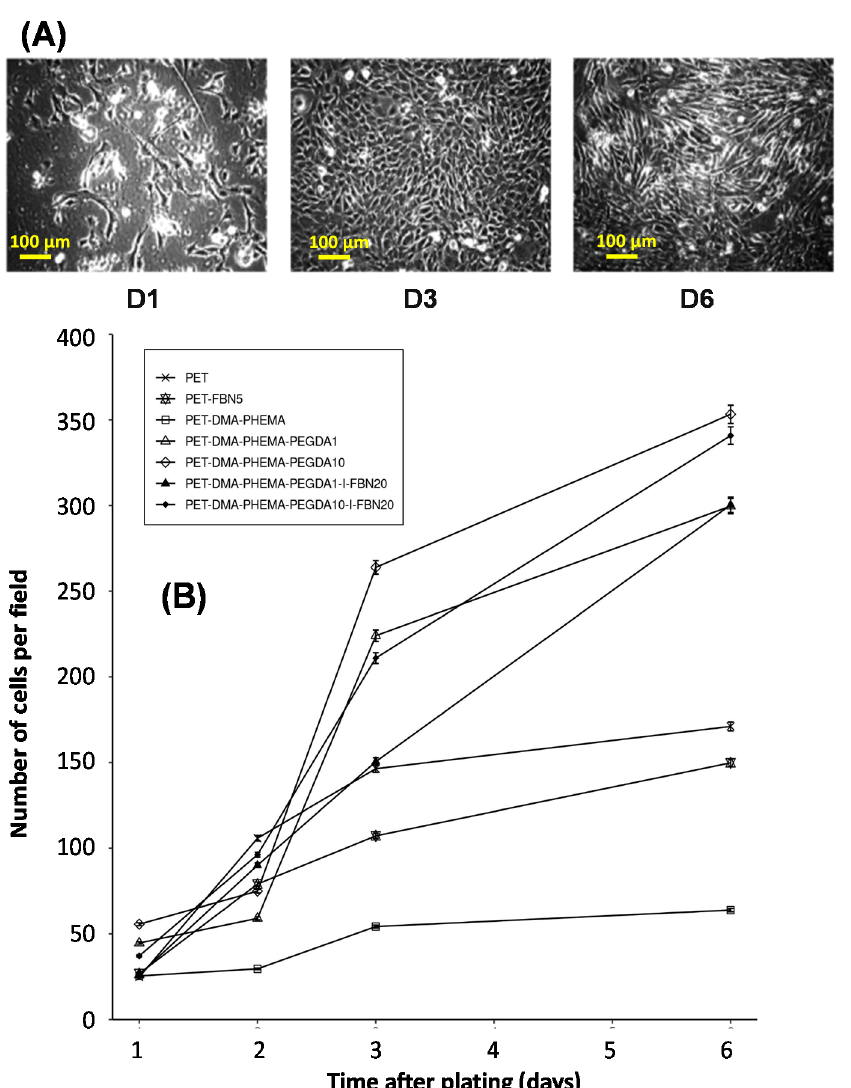
µg/mL respectively.